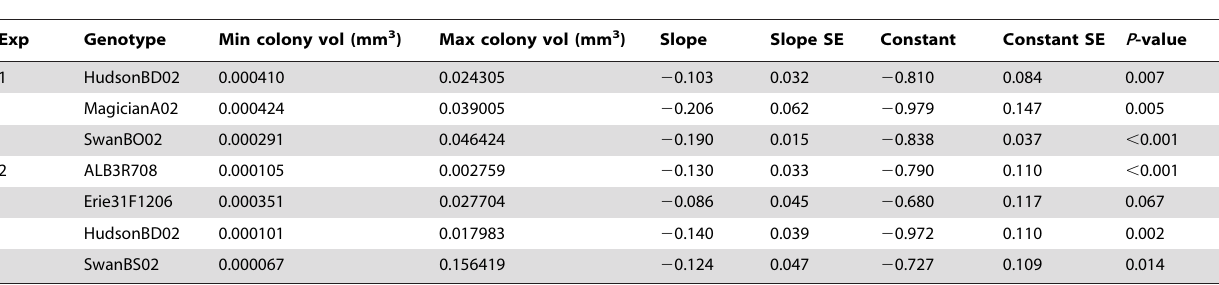
Table 2. Summary statistics for relationships between Microcystis aeruginosa colony growth rate and initial volume.